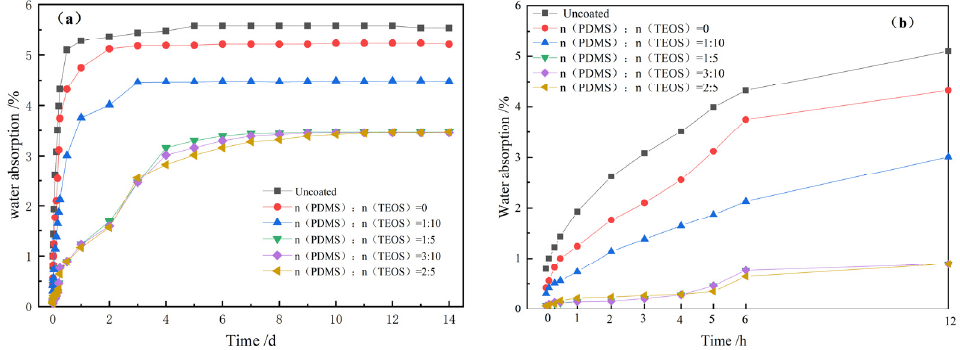
Figure 8. Water absorption of building walls with different PDMS and TEOS ratios. ( a ) Cumulative water absorption in 14 days. ( b ) Cumulative water absorption in 12 h. water absorption in 14 days. ( b ) Cumulative water absorption in 12